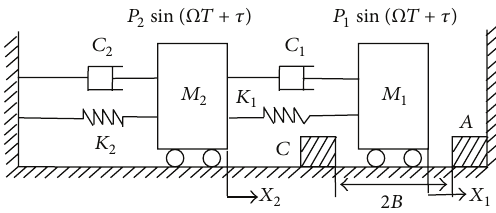
Figure 1: Schematic representation of a two-degree-of-freedom vibroimpact system with symmetrical rigid